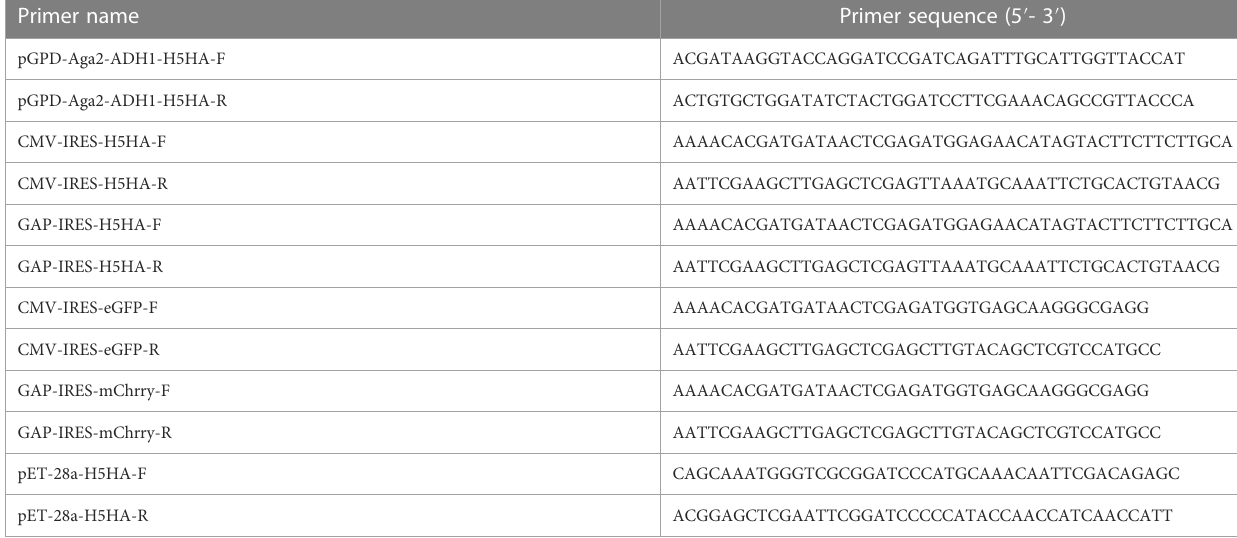
TABLE 1 PCR primers for expressing